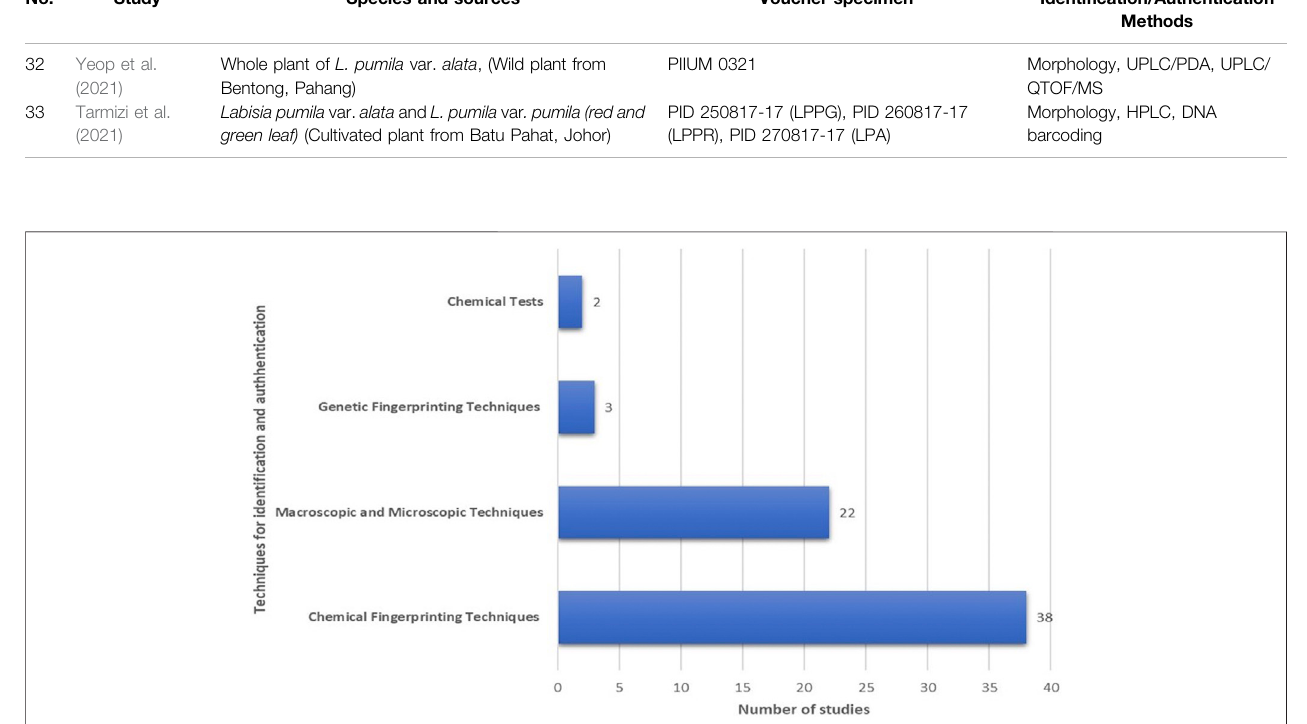
Frontiers in Pharmacology |